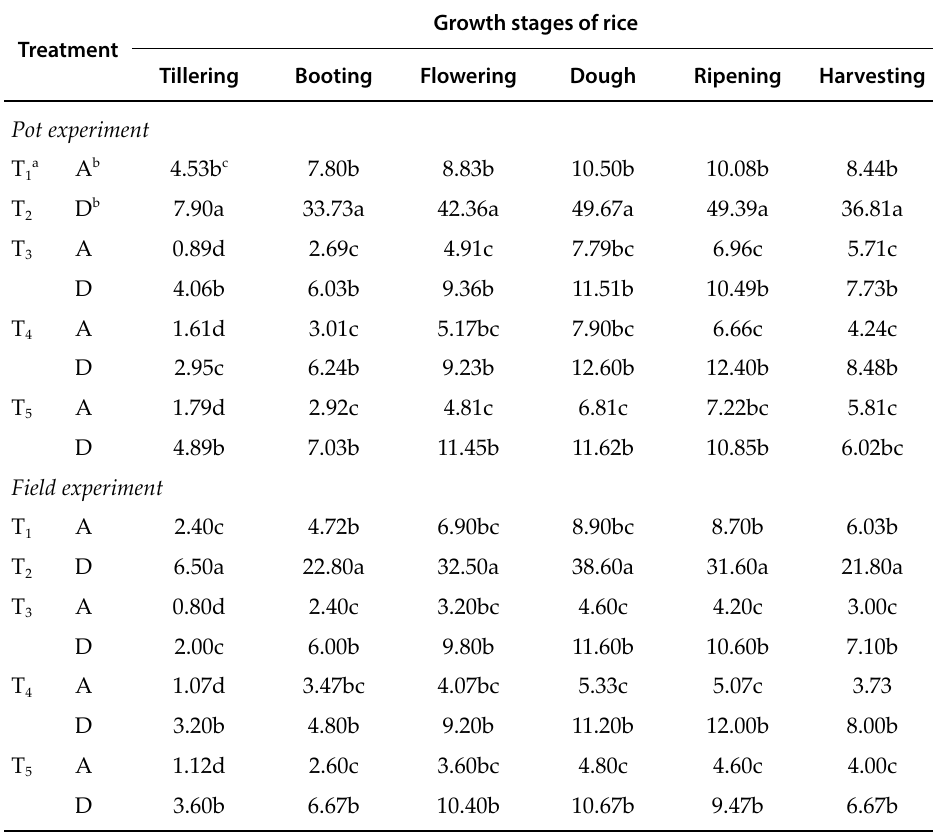
Table 2. Mean reproduction rates of two nematodes, Aphenchoides besseyi and Ditylenchus angustus , inoculated on rice plants at different inoculation ratios, in pot- and field-grown rice